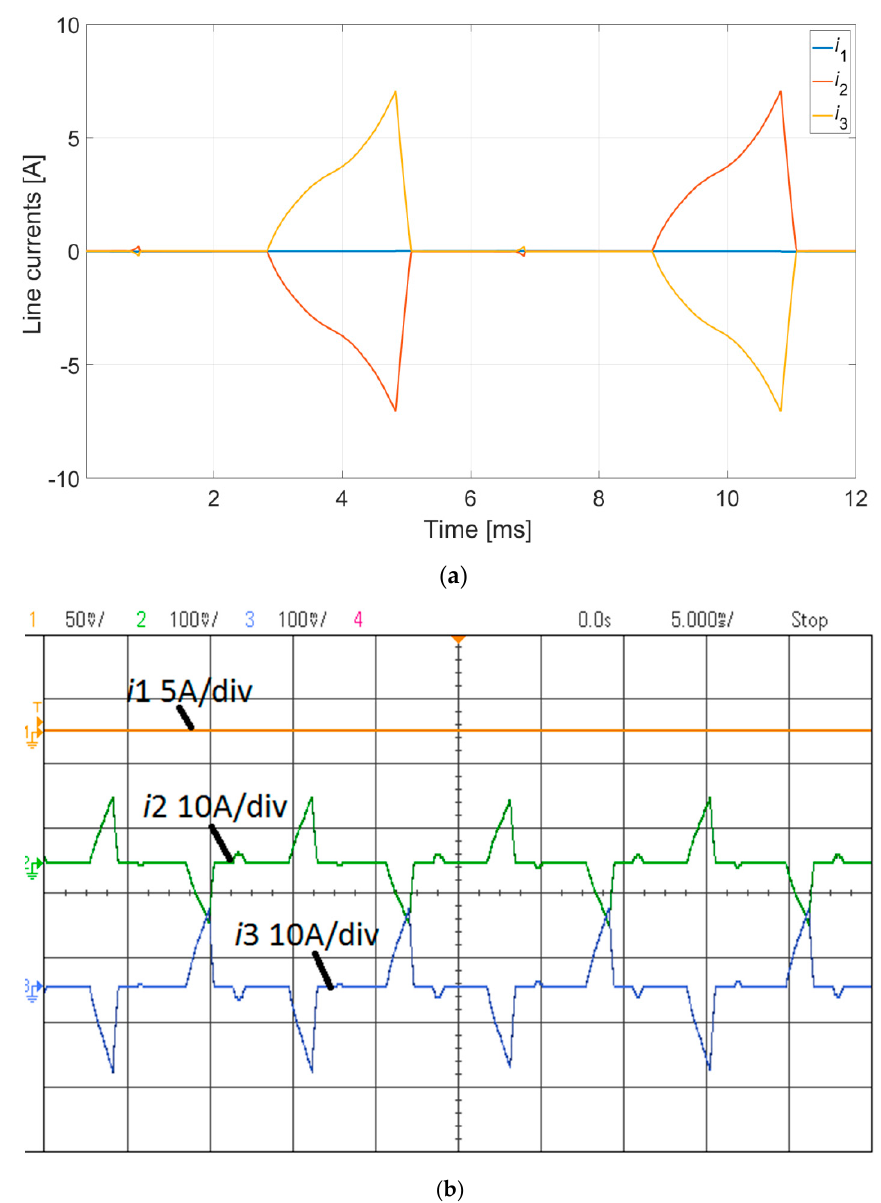
Figure 19. Star–delta (Y ∆ ) configuration—waveforms of line currents in fault state OC1: ( a ) numerical calculations; ( b ) measurements.